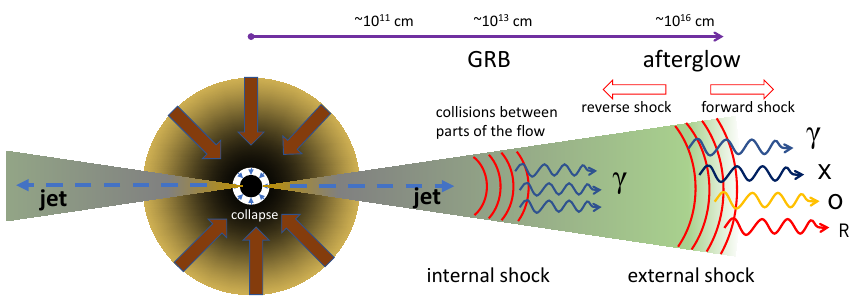
Figure 2. Schematic description of the fireball model of